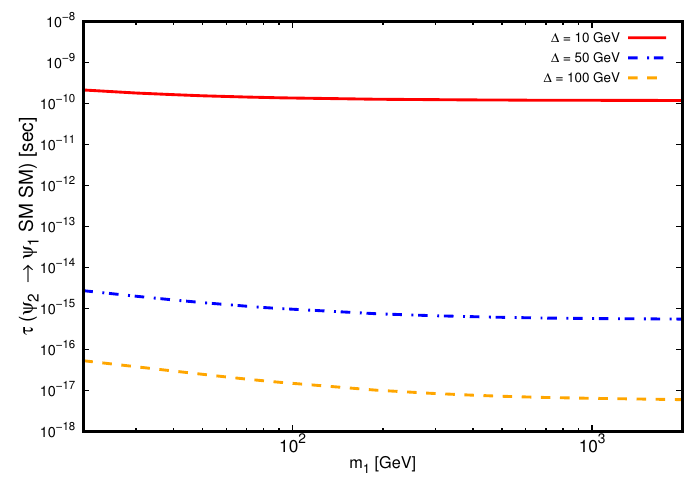
Figure 1 . The lifetime of the heavy fermion is provided for three values of the mass splitting, (cid:1) = 10 ; 50 ; 100 GeV. Chosen input parameters are: g 12 = 1, sin (cid:18) = 0 : 05 and m s = 300 GeV. f stands for the SM fermions. If the mass splitting is assumed to be (cid:1) < m